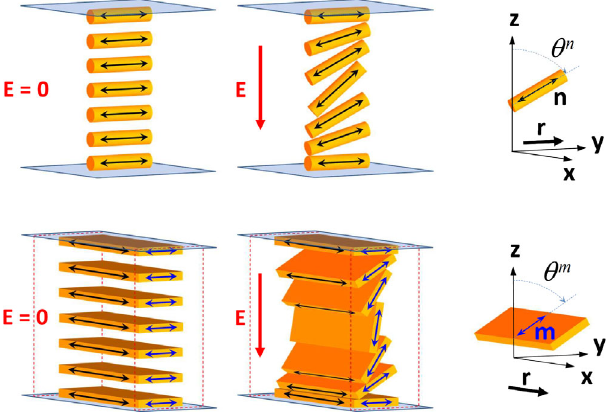
FIG. 10. Geometry of the distortions of n in the N phase (top row) and m in the Sm A phase (bottom row); in the left and b middle columns, the applied voltage is, respectively, below and above the Fr´eedericksz transition threshold. r is the rubbing direction, ð x ; y ; z Þ is a reference frame, θ n (respectively, θ m ) is the angle of the n (respectively, m ) director with the normal to the cell ( z axis). The smectic layers are shown in red.